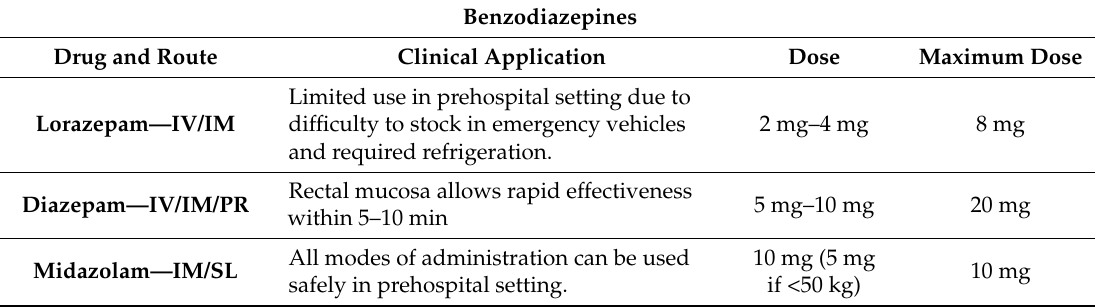
Table 2. Prehospital Management of Status Epilepticus. Regardless of the choice of benzodiazepine, no increased frequency of adverse outcomes was appreciated, as per the Prehospital Treatment of Status Epilepticus (PHTSE) Trial [2,17,22–24,26,27]. Benzodiazepines Drug and Route Clinical Application Dose Maximum Dose Limited use in prehospital setting due to Lorazepam—IV/IM difficulty to stock in emergency vehicles 2 mg–4 mg 8 mg and required refrigeration. Rectal mucosa allows rapid effectiveness Diazepam—IV/IM/PR 5 mg–10 mg 20 mg within 5–10 min All modes of administration can be used 10 mg (5 mg Midazolam—IM/SL 10 safely in prehospital setting. if <50 kg)